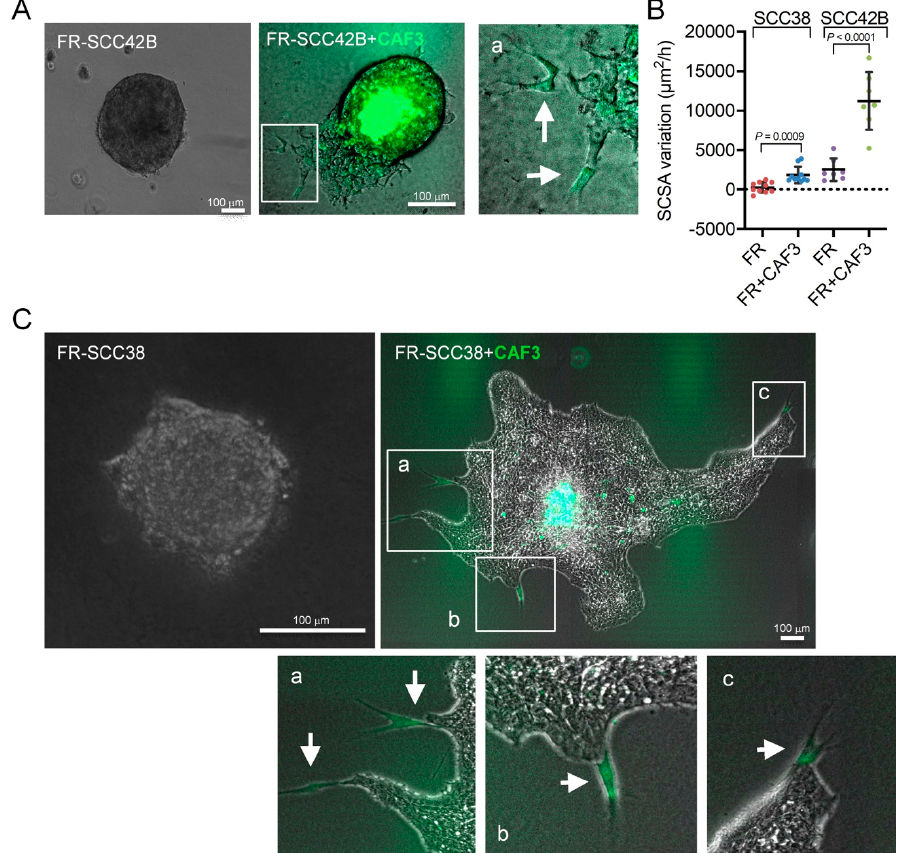
Figure 2. Cancer-associated fibroblasts (CAFs) promote collective invasion of FRNK-SCC cells by acting as leaders of the invasive fronts. ( A , C ) Representative images of spheroids assembled with FR-SCC cells or with mixed populations of SCC cells and CAFs as indicated and incubated for 20 h ( A ) or 6 days ( C ). CAFs were labeled with green 5-chloromethylfluorescein diacetate (CMFDA) to allow their tracking over time. Magnified images in panel ( A ) ( a ) and ( C ) ( a – c ) are shown to better visualize the leader CAFs (denoted by white arrows) at the tip of the invasive cell tracks. ( B ) Variations over time of the spheroid cross-sectional area (SCSA) of the spheroids assembled with the indicated cells.